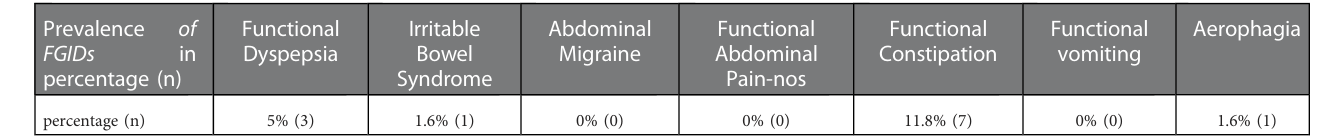
TABLE 2 Incidence of FGIDs among the recruited pilot data.